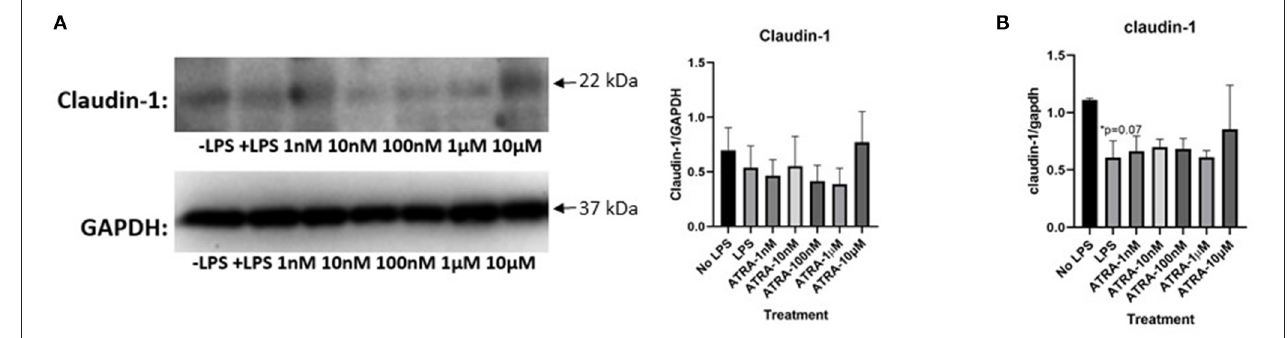
FIGURE 5 | ATRA is not as effective as in causing similar tight junction expression trends as β -carotene. (A,B) ATRA treatments on tight junction proteins or mRNA. (A) Claudin-1 WCL protein in western blot (B) and claudin-1 mRNA expressions in qPCR. Five treatment doses of ATRA (1, 10, 100nM, 1, 10 µ M). Four replicates were used for statistical analysis in western blot and PCR. Values are means ± SEMs. *Significance at p < 0.05 for comparison with the “No LPS”